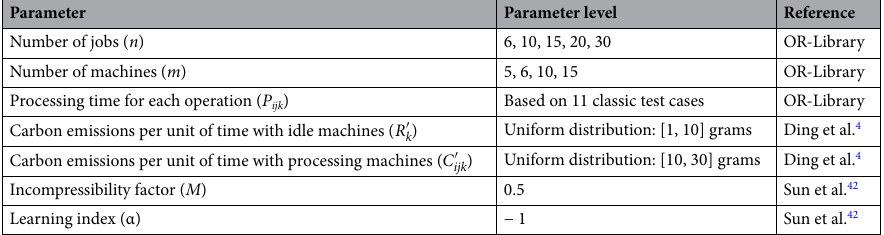
Table 3. Parameters used in the experiments.